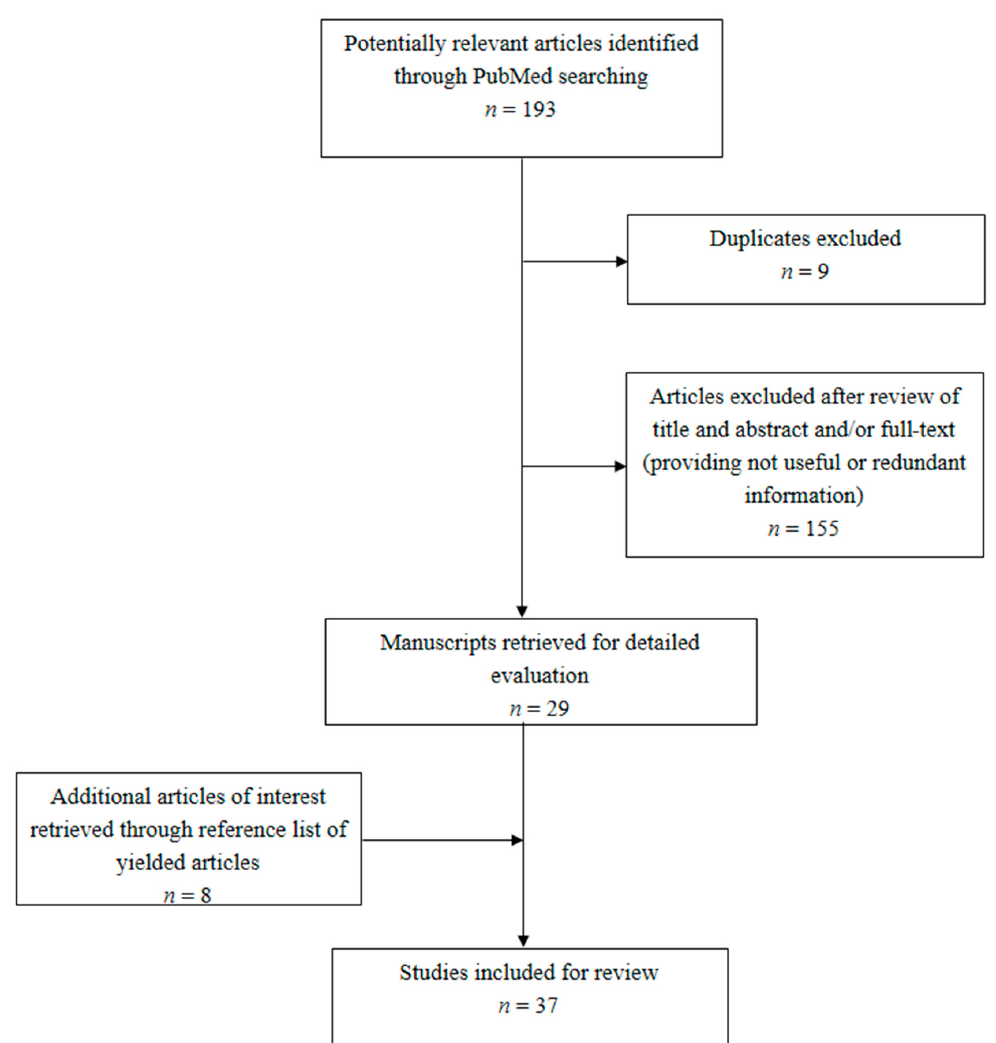
Figure 1. Flow chart of the literature selection process regarding clinical and laboratory studies on lopinavir/ritonavir association (LPV/r) use in COVID-19, severe acute respiratory syndrome (SARS), and Middle East respiratory syndrome (MERS).